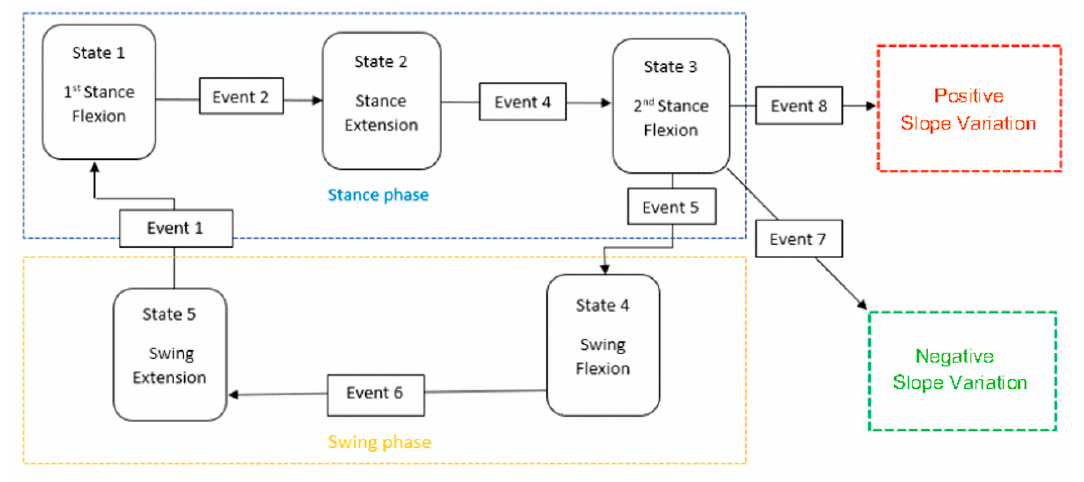
Figure 8. Finite-state-machine modeling of the prosthesis control scheme that takes into account the longitudinal slope of the walking.